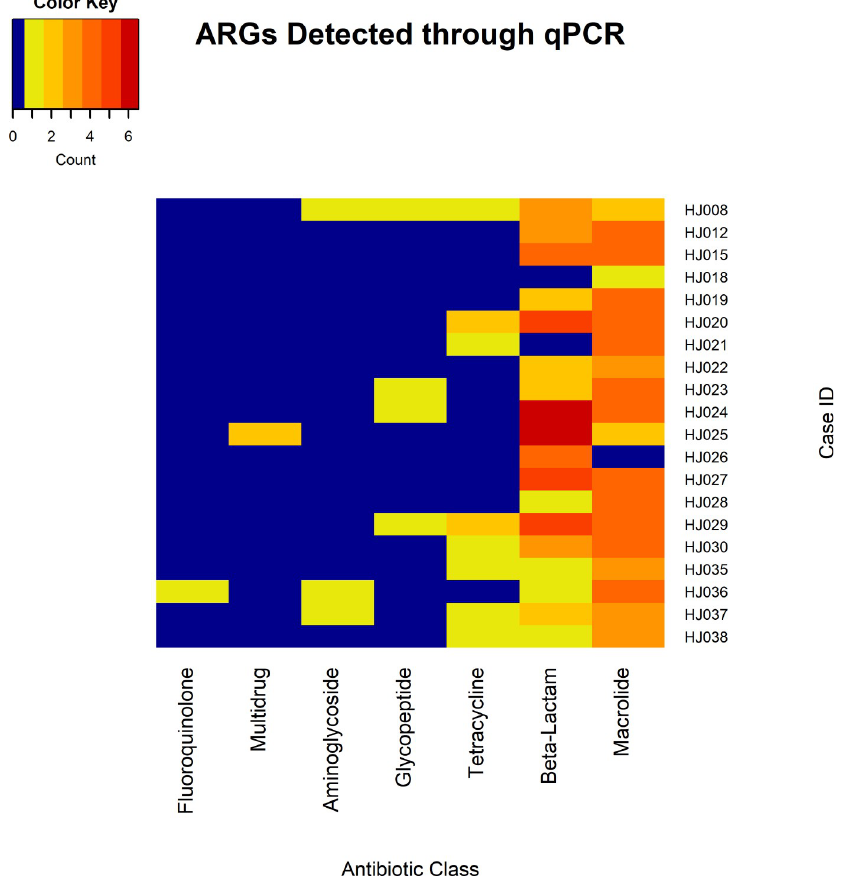
Fig 4. Heatmap visualization of genes related to particular antibiotic classes found in each case through using ARG qPCR arrays. Resistance genes to fluoroquinolones, multidrug efflux pumps, aminoglycosides, glycopeptides, tetracyclines, beta-lactams, and macrolides were discovered. Color and numbers represent the range of abundance of genes found to inhibit antibiotic classes. Blue represents no detection and red the highest detection.